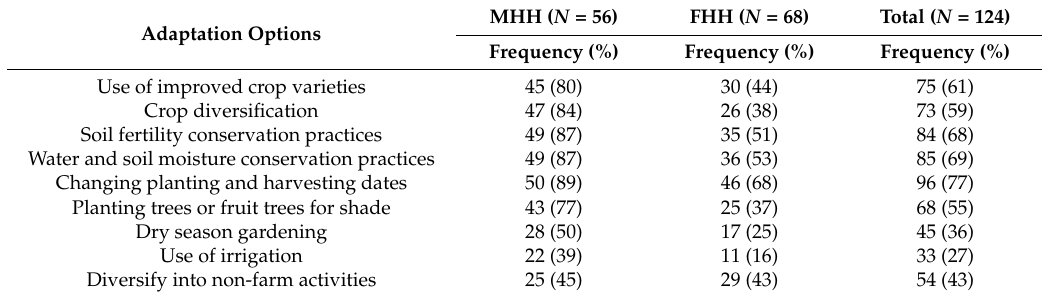
Table 2. Gender differences in climate change adaptation practices among farm household